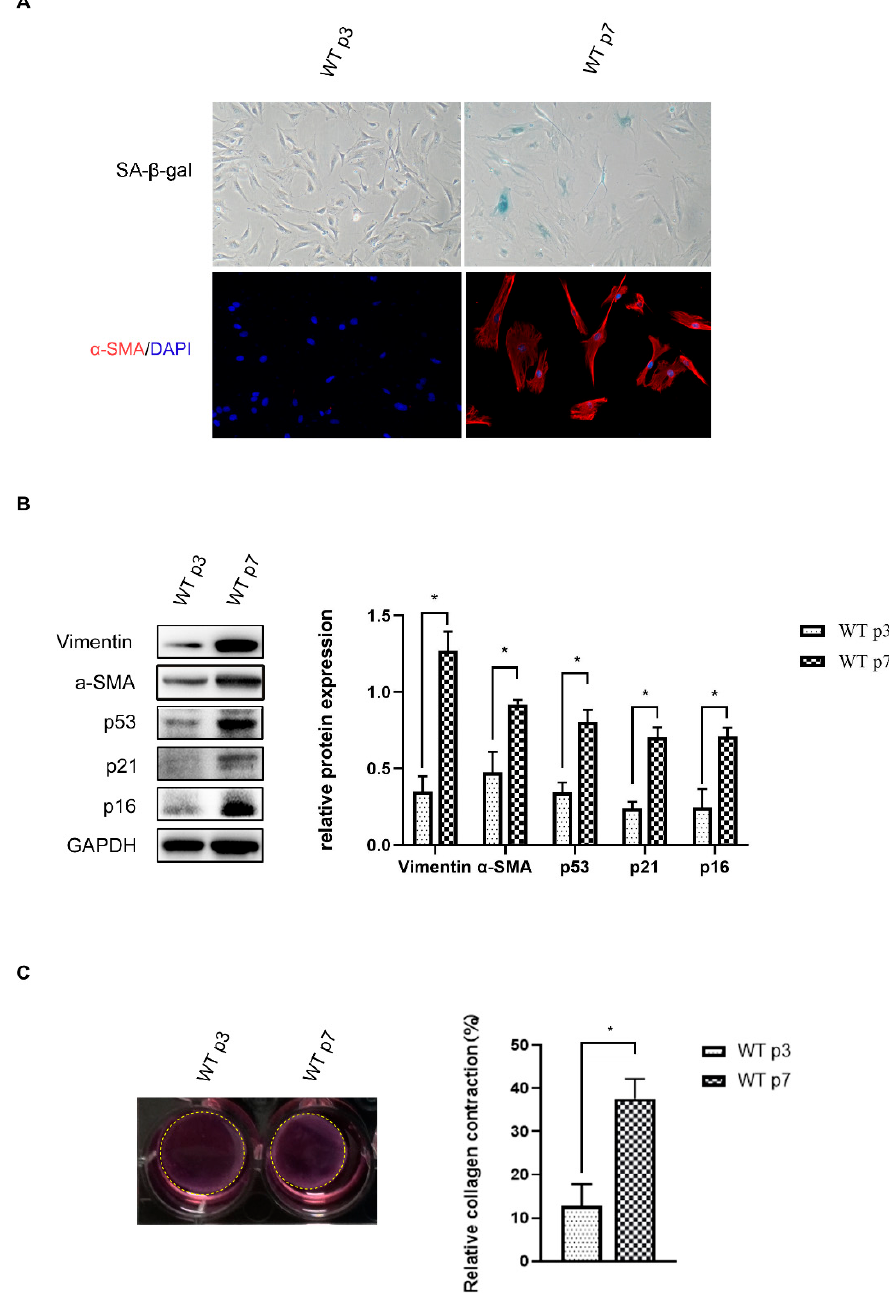
Figure 1. Fibroblast senescence coupled with acquisition of CAF properties. ( A ). Representative images of SA- β -gal staining of early-passage fibroblasts ( p = 3) and late-passage fibroblasts (p7). Late-passage fibroblasts display increased activity of senescence-associated β -galactosidase (SA- β -Gal, blue) and upregulated CAF marker α -SMA (red). ( B ). The expression of α -SMA, Vimentin, p53, p21 and p16 in fibroblasts were analyzed by Western blotting. Diagrams represent α -SMA, Vimentin, p53, p21 and p16 protein levels as means ± SEM of densitometric quantifications of two independent experiments (n = 2) normalized to GAPDH. Statistical analysis; *, p < 0.05. ( C ). Fibroblasts were subjected to a collagen contraction assay and imaged after 24 h. Quantification of the collagen contractile activity, statistical analysis, *, p < 0.05.